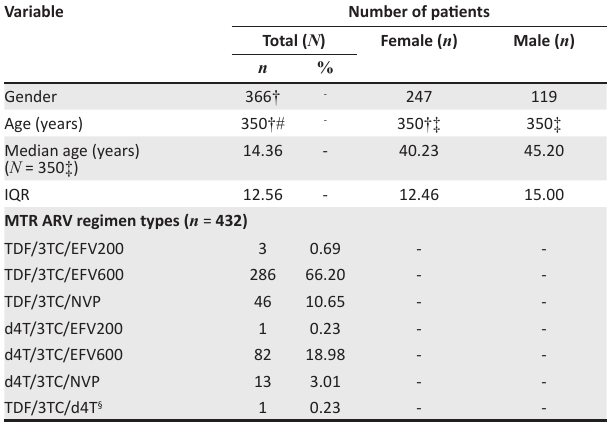
TABLE 1: Demographic profile and multiple-tablet regimen types.